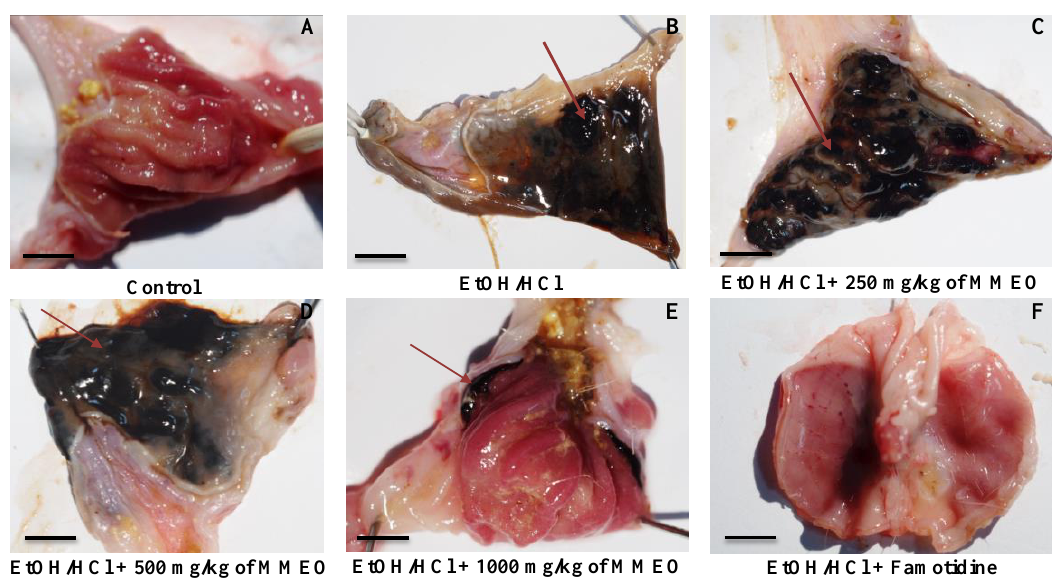
Figure 2 . Photomicrographs showing mucosal surface of rat stomach, ( A ) stomach from control rat, ( B ) Stomach from rat treated with EtOH/HCl. Arrows indicate hemorrhage sites. ( C , D , E ): Stomach from rat treated with 250, 500 and 1000 mg/kg of MMEO, respectively + EtOH/HCl. ( F ): rat treated with 20 mg/Kg of famotidine + EtOH/HCl. Bar: 1 cm.